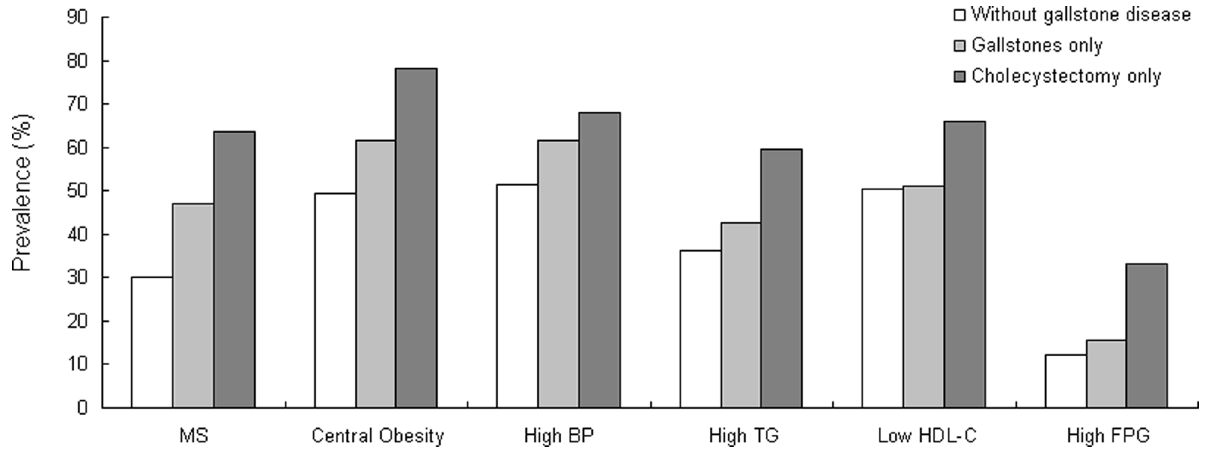
Figure 1. Prevalences of metabolic syndrome and each of its component features. The prevalences of metabolic syndrome and each of its component features in individuals with gallstones were higher than the prevalences in individuals without gallstones, and higher still in those who had undergone cholecystectomy (all with P for trend , 0.001). BP, blood pressure; TG, triglyceride; HDL-C high-density lipoprotein cholesterol; FPG, fasting blood glucose.